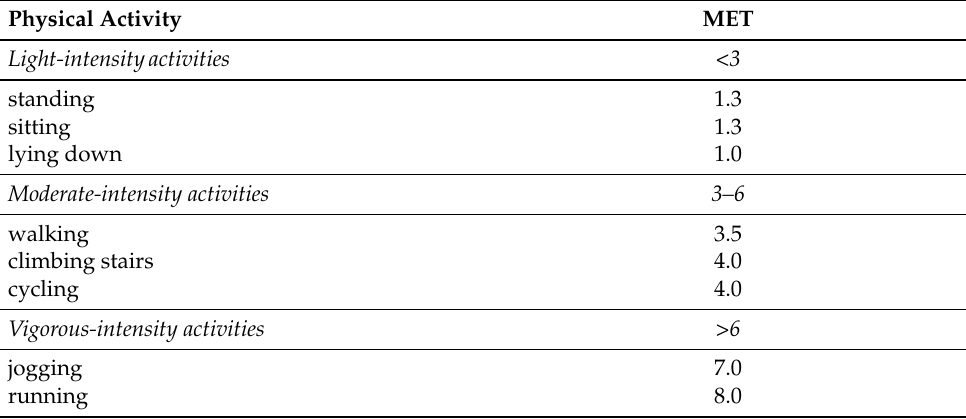
Table 1. Physical activities and MET